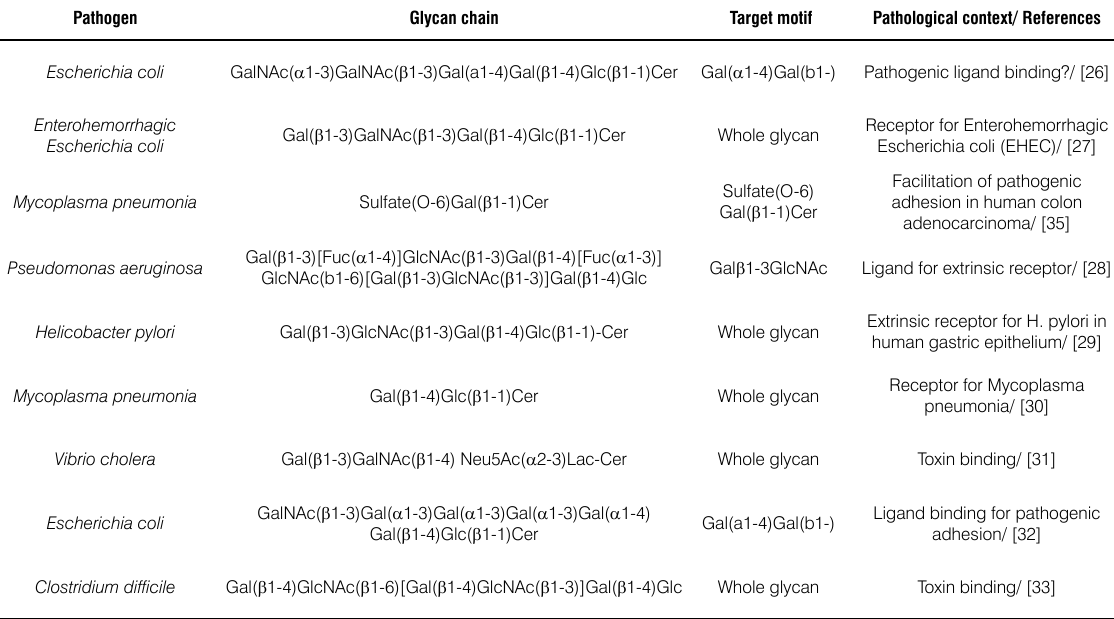
Table 1. Glycosylation patterns of Gal β 1-3GlcNAc β 1- to form A, B, H and Lewis blood group antigens